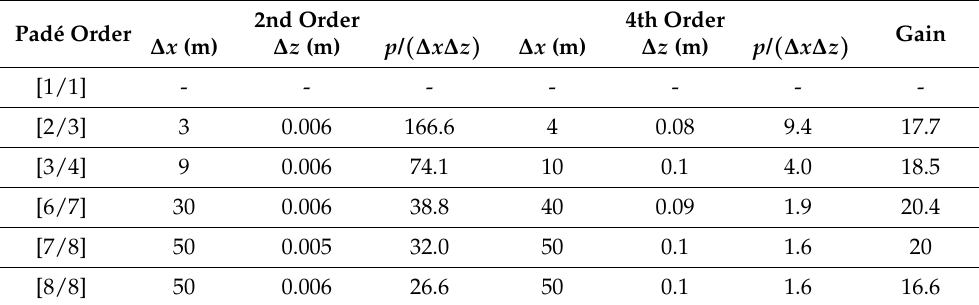
Table 3. Optimal values of the cell sizes. ε = 10 − 3 , x max = 1000 m, θ max = 30 ◦ , f = 500 Hz, c 0 = 1591